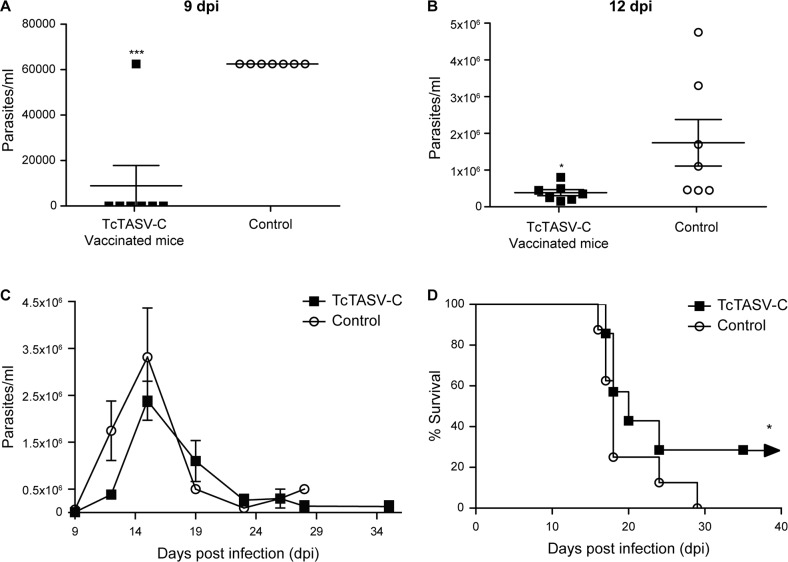
Parasitological outcome of TcTASV-C vaccinated mice challenged with a virulent T. cruzi strain.Groups of mice (n = 5) were immunized with TcTASV-C or vehicle (Control) and challenged with T. cruzi trypomastigotes of the RA strain (TcVI) 15 days after the last dose. Animals were followed up for parasitemia and survival. Parasitemia of individual mice at 9 (A) and 12 (B) days post-infection. (C) Parasitemia during the course of infection in TcTASV-C vaccinated and Control groups (*p<0.05 and ***p<0.005 vs control; Mann-Whitney test). (D) Survival curve of challenged TcTASV-C vaccinated and Control groups (**p<0.05 vs Control group; Log-Rank test).